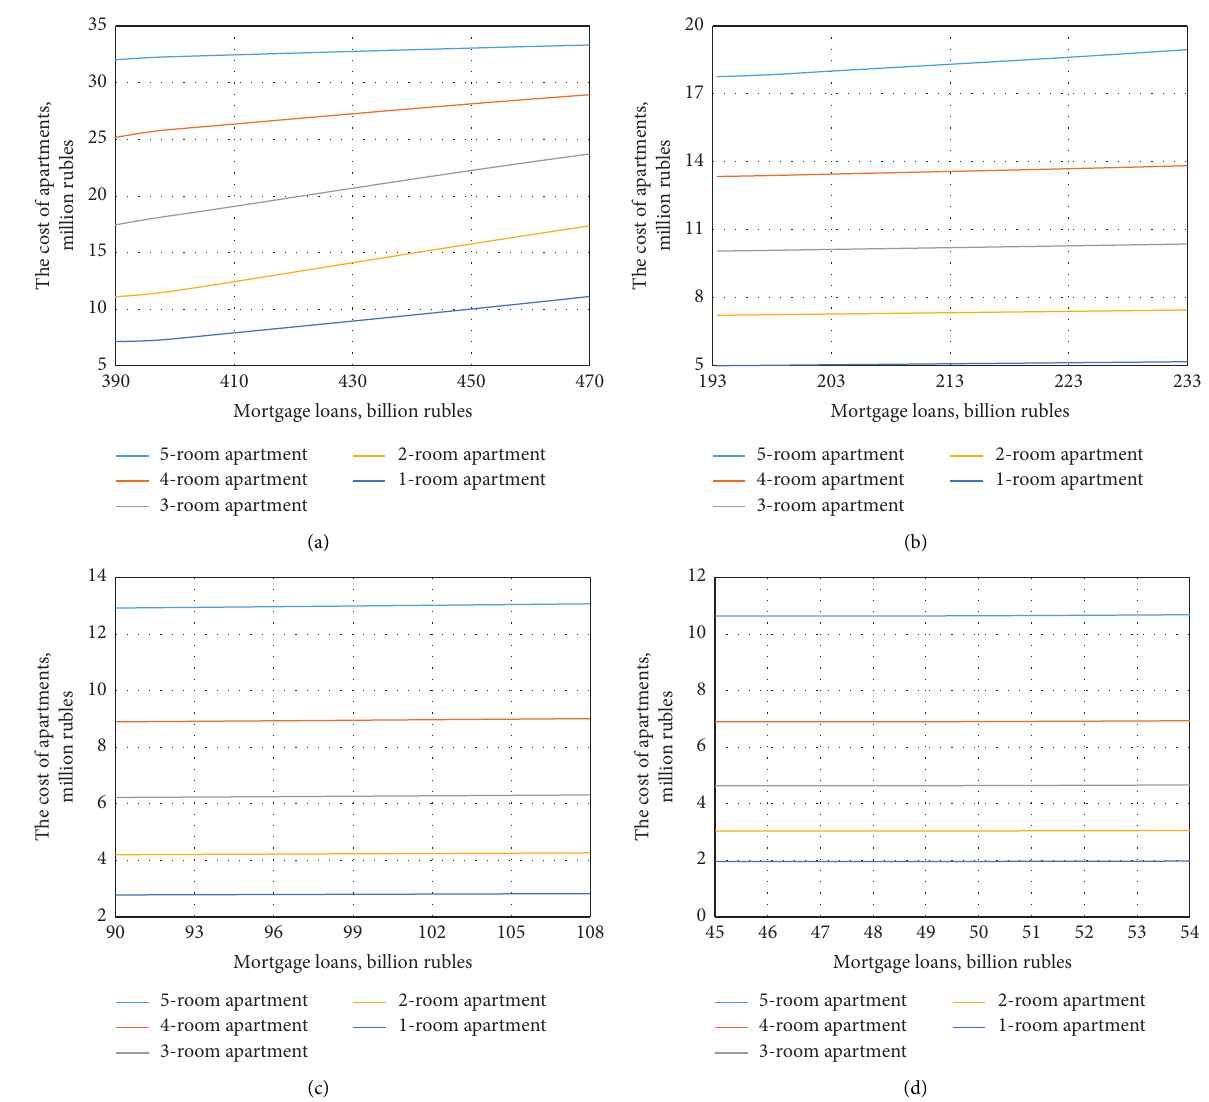
Figure 8: Forecast of the dependence of apartment costs in Russian cities on the volume of mortgage lending. (a) Moscow, (b) Saint Petersburg, (c) Yekaterinburg, and (d)